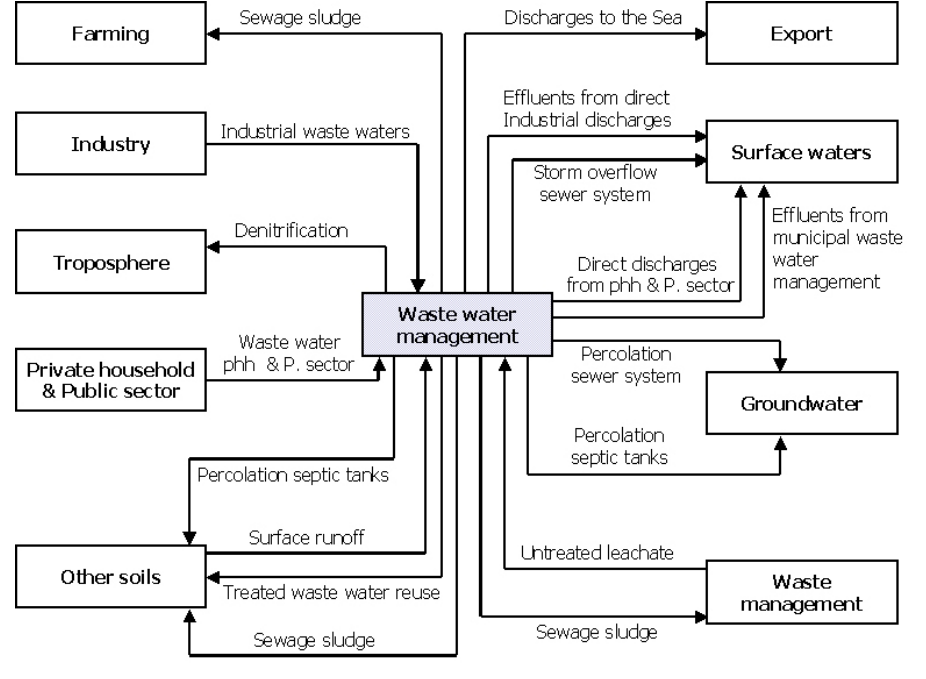
FIGURE 3. System definition as applied for nitrogen compound balance in Catalonia considering the wastewater management